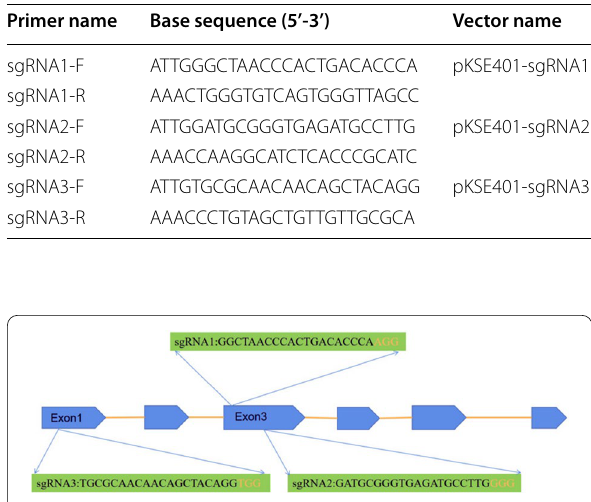
Fig. 1 Schematic diagram of three sgRNA targeting sites for Dschyb locus. Blue module represents exon; Orange line represents intron; Orange marked sequence is PAM